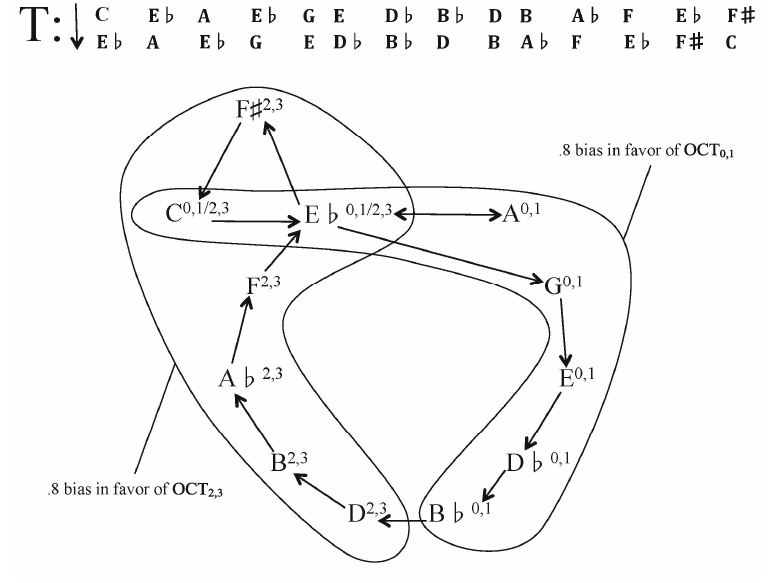
Figure 14. Biased analysis of Many Many Cadences (Macklay 2014), measures 1–6, (compare with Example